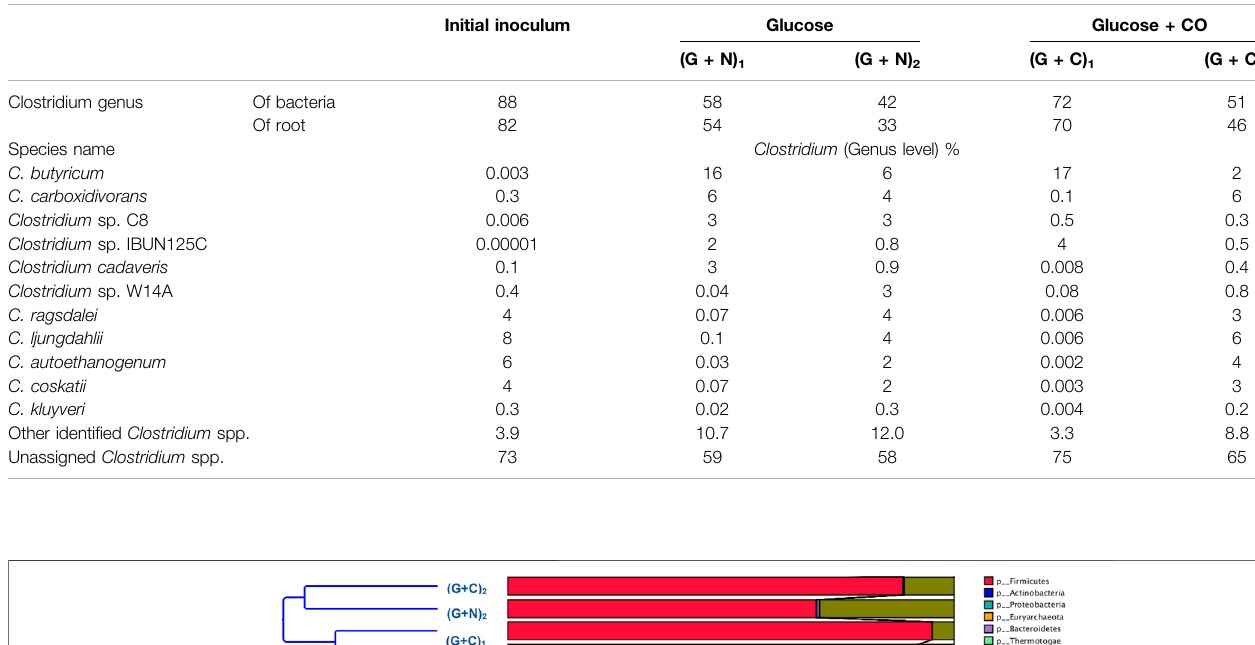
TABLE 3 | Relative abundance of Clostridium spp. at species level in Glucose + CO and Glucose + N 2 by enriched sludge from 6 th transfer. Initial inoculum Glucose Glucose + CO (G + N) 1 (G + N) 2 (G + C) 1